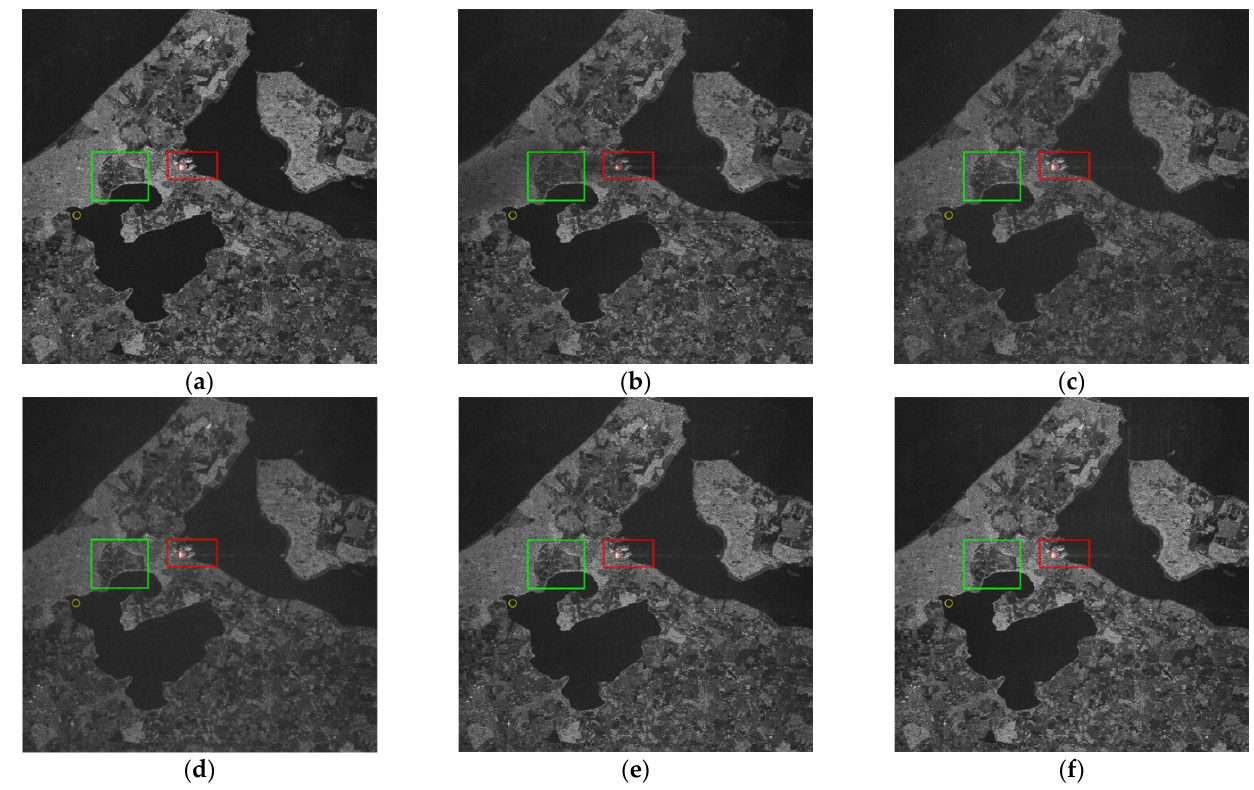
Figure 14. Resulting SAR image after applying ( a ) the SAR imaging algorithm applied directly for the measured SAR data, ( b ) ISNF, ( c ) ESP, ( d ) GoDec, ( e ) LRDS, and ( f ) TFC-LRS.